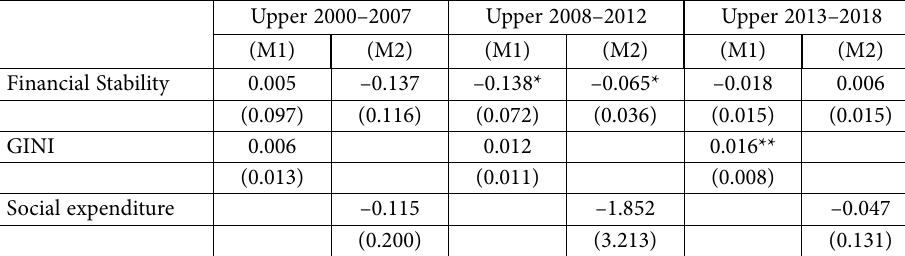
Table 5.2. Upper